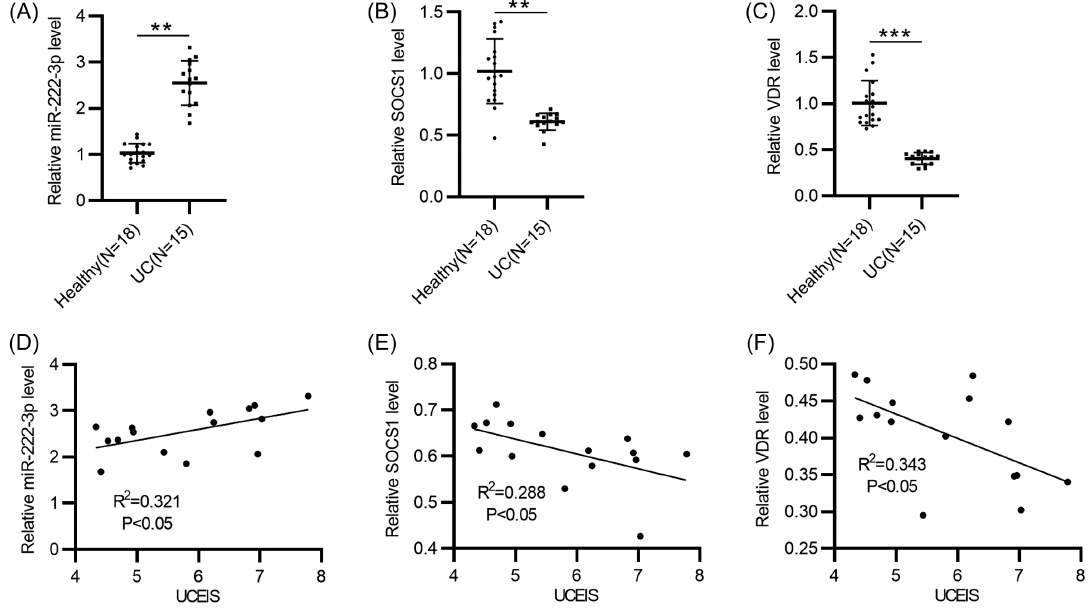
Figure 6. Correlations between molecule expression and endoscopic scores (UCEIS) in UC patients. Comparison of miR-222-3p (A), SOCS1 (B), and VDR (C) expression between healthy controls and UC patients. The levels of (D) miR-222-3p, (E) SOCS1 , and (F) VDR were correlated with the endoscopic score of UC (UCEIS). Correlations were assessed by Spearman’s correlation coefficient. ** P < .01, *** P < .001. UC, ulcerative